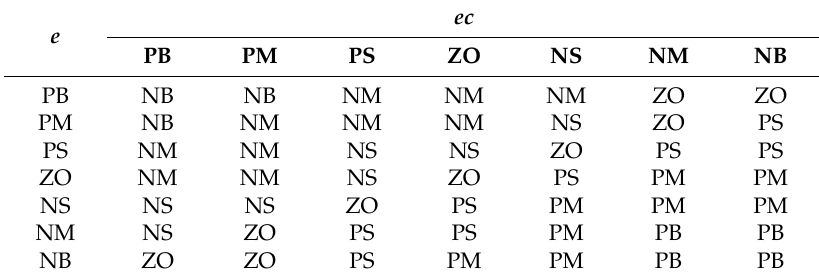
Table 2. Fuzzy control rule table of (cid:52) k p .